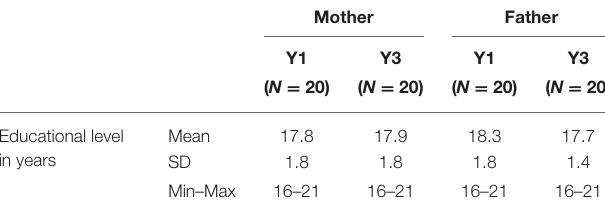
TABLE 2 | Descriptive statistics Parental Educational Level in